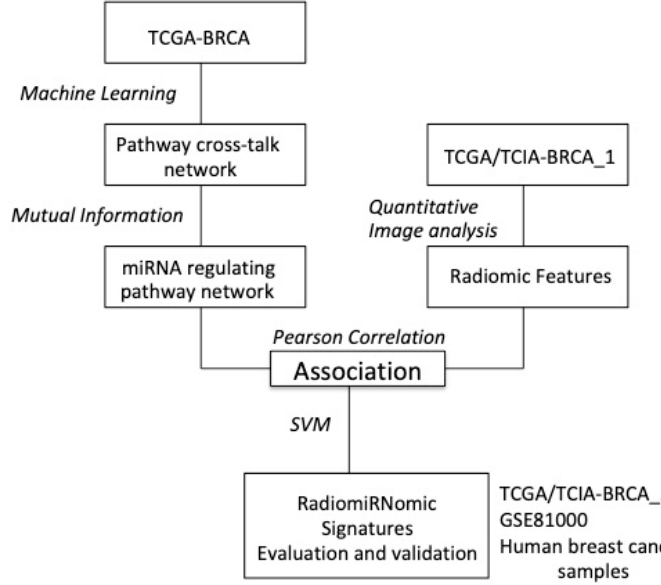
Figure 6. Workflow of the proposed approach .